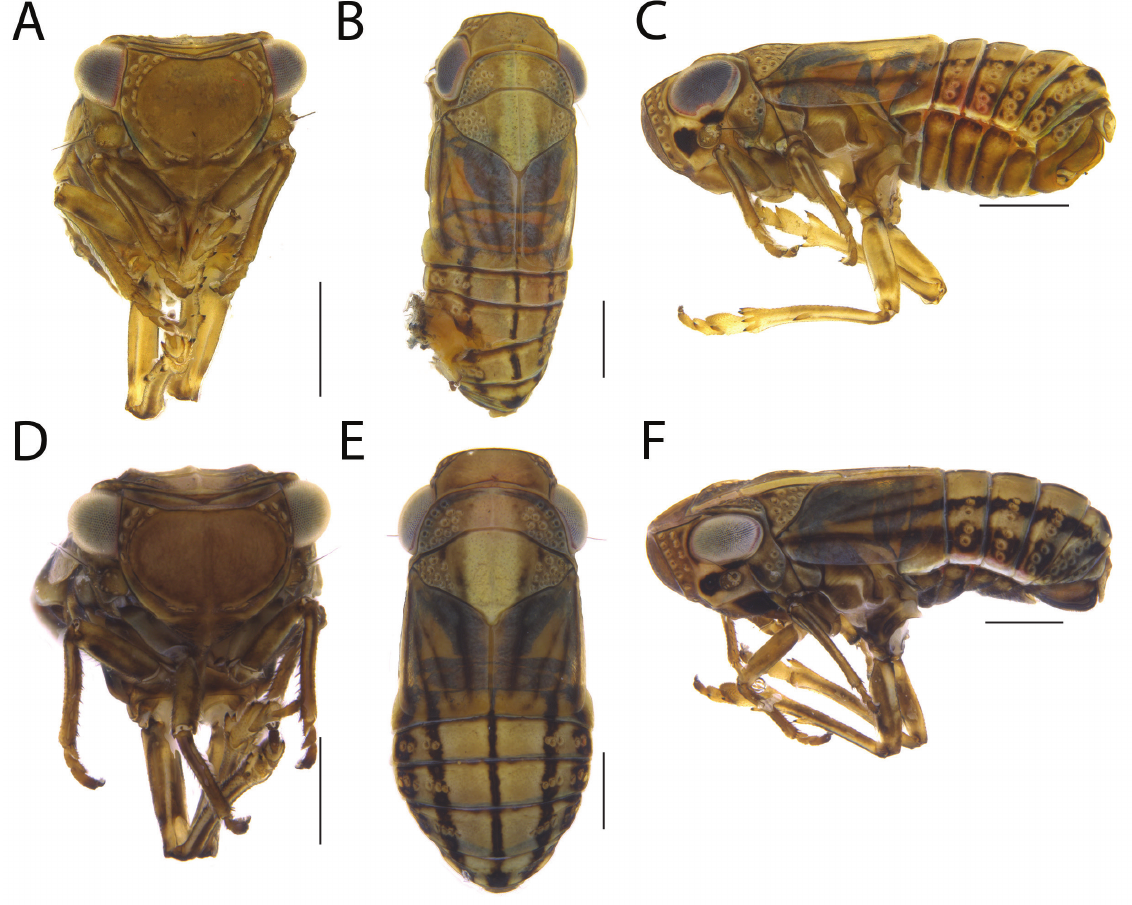
Fig. 18. Habitus of Protrocha nesolitaria (Caldwell, 1945). A–C . ♂ (INHS). A . Frontal view. B . Dorsal view. C . Lateral view. D–F . ♀ (INHS). D . Frontal view. E . Dorsal view. F . Lateral view. Scale bars = 0.5